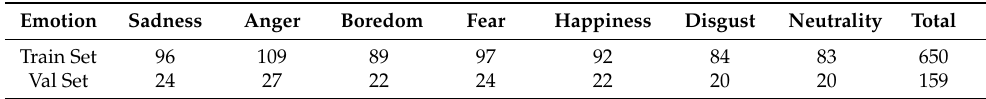
Table 5. Data statistics of the